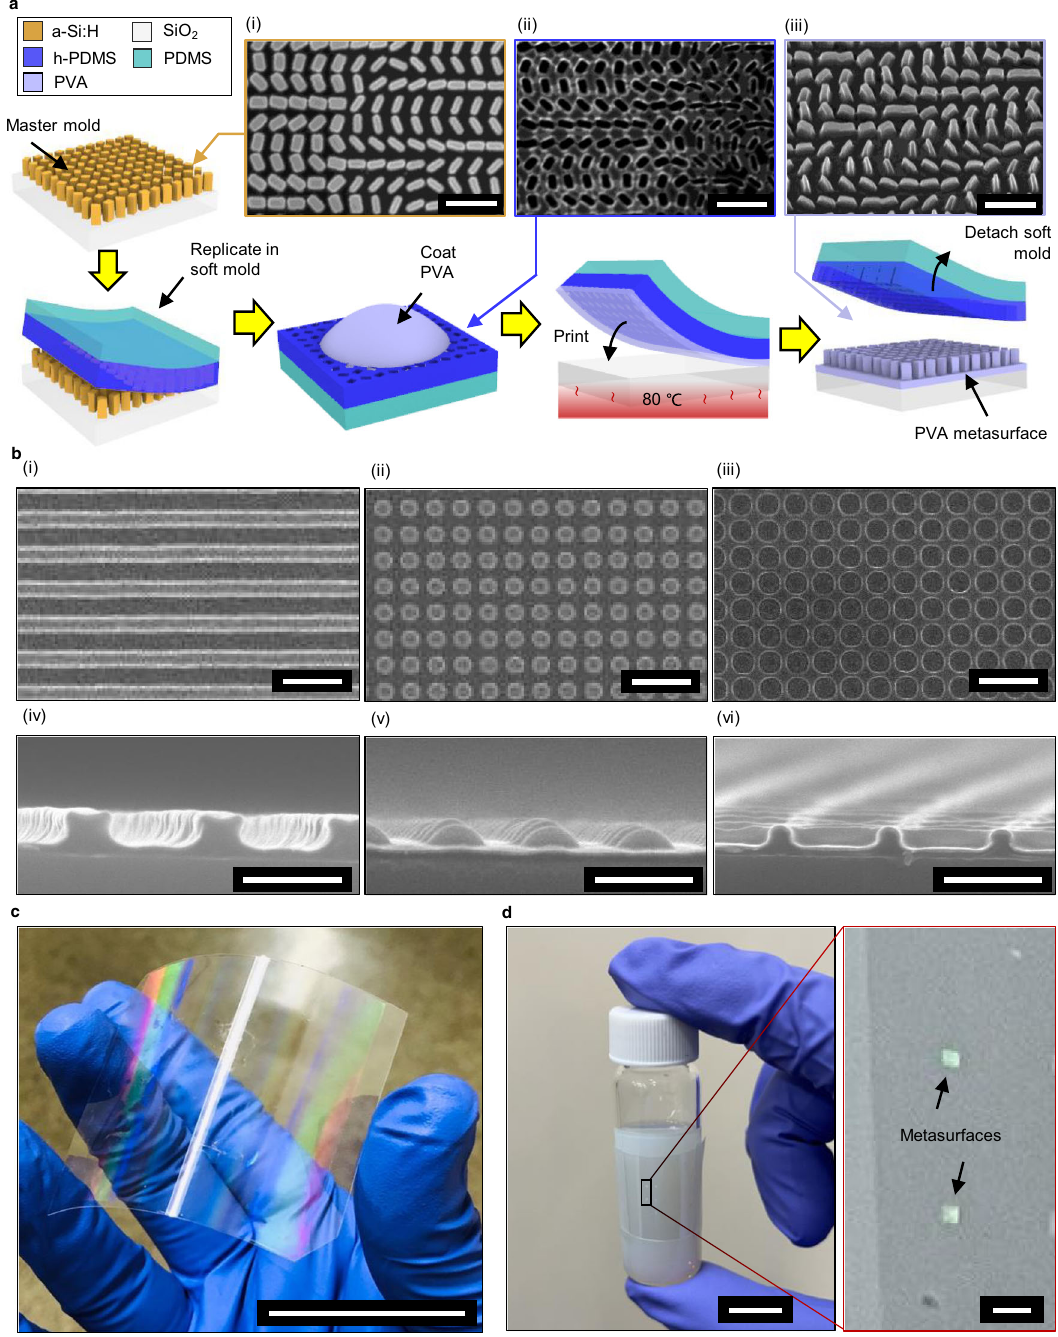
Fig. 2 | Fabrication of polyvinyl alcohol nanostructures using nanoimprint lithography. a The nanoimprint lithography (NIL) process for polyvinyl alcohol (PVA).(i)Themastermoldisfabricatedusingelectron-beamlithography(EBL)and (ii) a negative soft mold is casted using polydimethylsiloxane (PDMS). The soft moldisthencoatedwithPVA,andtheNILprocessisconductedtoproduce(iii)PVA metasurfaces. All scale bars: 1 µ m ( b ) Scanning electron microscope (SEM) images